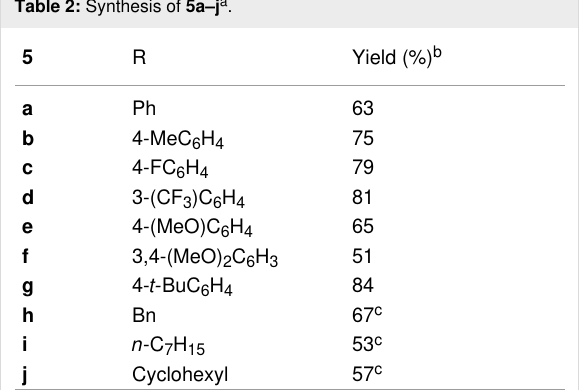
Nucleotide pyrophosphatase activity Nucleotide pyrophosphatases belong to the family of ecto- nucleotidases [34,35]. They can hydrolyze nucleotides, dinu- cleotides, and nucleotide sugars, e.g., ATP, ADP, NAD + , ADP- ribose and diadenosine polyphosphates [36]. The isozymes of NPPs are involved in the pathophysiology of different diseases, such as calcification, cancer, and insulin resistance [34,35].